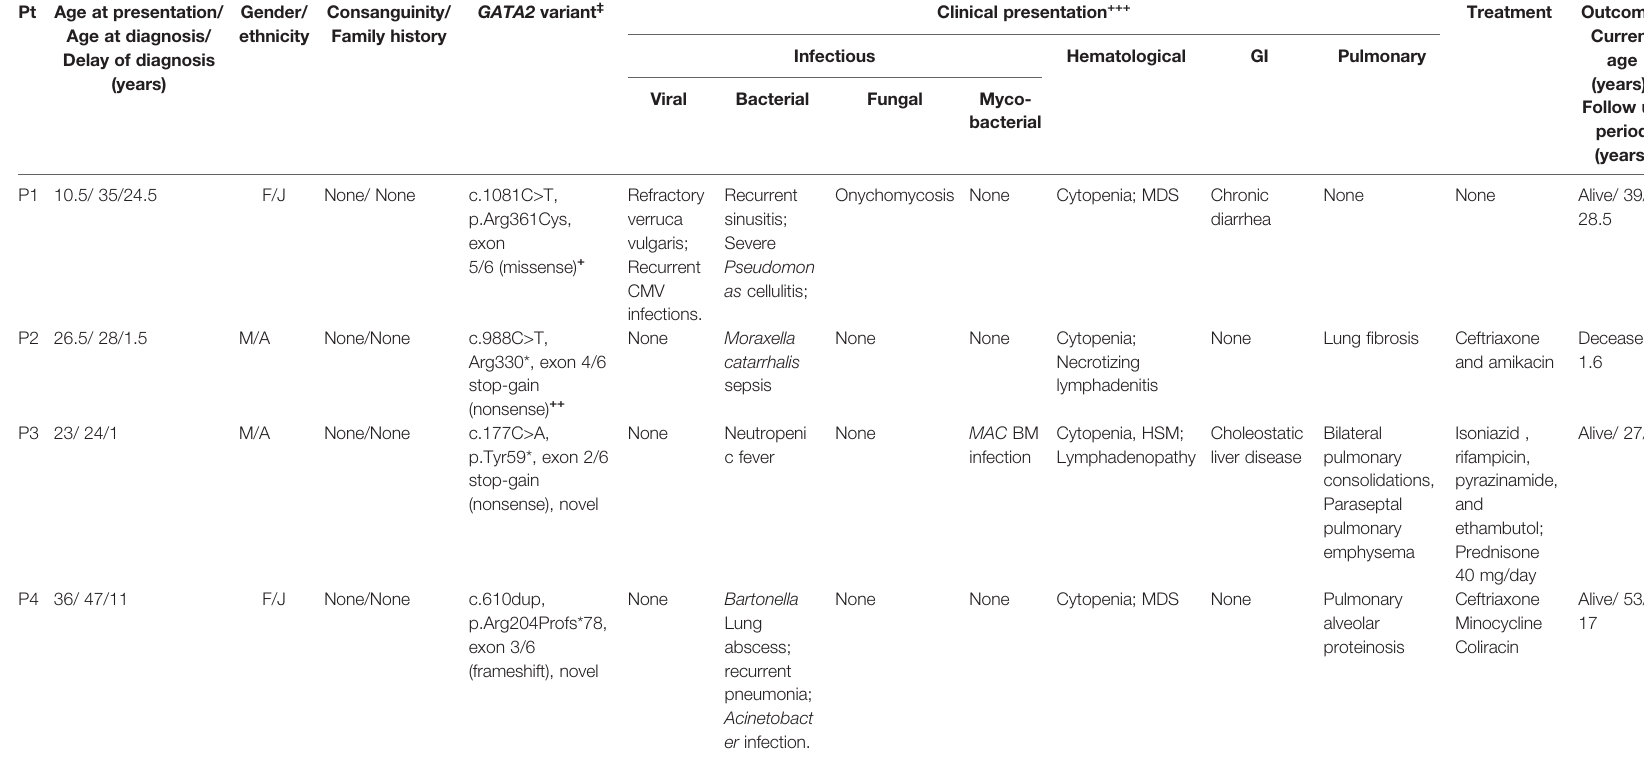
TABLE 1 | Clinical characteristics of GATA2-de fi cient patients. Pt Age at presentation/ Age at